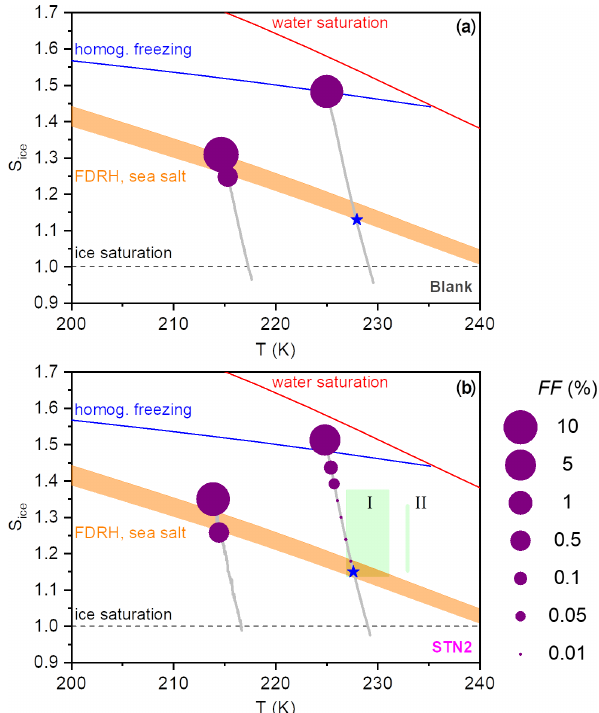
Figure 6. Illustration of the ice nucleation behaviour observed dur- ing the AIDA expansion runs with the particles generated from the bulk Atlantic water sample (blank (a) ) and the STN2 microlayer sample (b) . The S ice versus T trajectories of the AIDA experi- ments are shown as the grey lines. The dashed black line denotes ice-saturated conditions, the red line displays the saturation curve with respect to supercooled liquid water, the homogeneous freez- ing onset of aqueous solution droplets is indicated by the blue line (Koop et al., 2000b), and the shaded orange area shows an esti- mate for the RH range of the full deliquescence (FDRH) of inor- ganic sea salt particles as discussed in the text. Blue stars denote measured FDRH onsets using the SIMONE light scattering data. The size of the purple-coloured dots superimposed on the trajec- tories represents the FF values encountered during the expansion runs. The green box labelled I denotes the range of onset condi- tions (FF = 1%) for ice nucleation on the particles from the micro- layer samples investigated by Wolf et al. (2020) (eastern tropical North Pacific Ocean and Florida Straits, temperature range 227– 231K). The green bar labelled II represents the range of ice nucle- ation onsets (FF = 1%) observed in the experiments by Wilson et al. (2015) (aerosolised microlayer samples from the North Pacific and the British Columbia coastline probed at